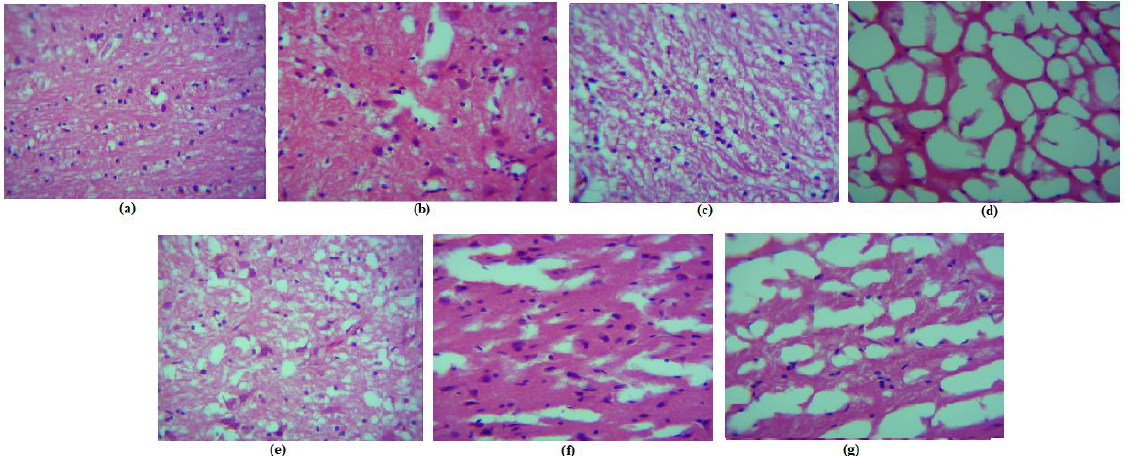
Figure 12. Brain histopathology of rats after sacrifice following the treatments for a period of 21 days ( a ) normal ( b ) diseased ( c ) BLNPs Treated (500 µg/kg BW) ( d ) silymarin Treated (10 mg/kg BW) ( e ) SLNPs Treated (500 µg/kg BW) ( f ) Zn Treated (10 mg/kg BW) ( g ) ZSLNPs Treated (10 mg/kg BW + 500 µg/kg BW).